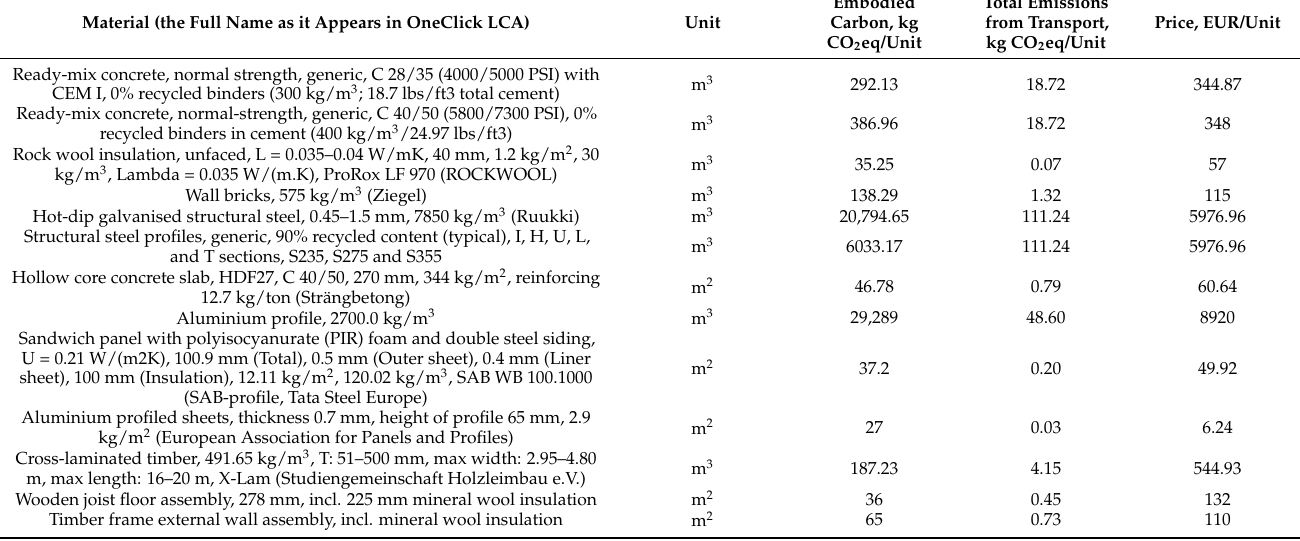
Table 1. Characteristics of materials that were used in this study.